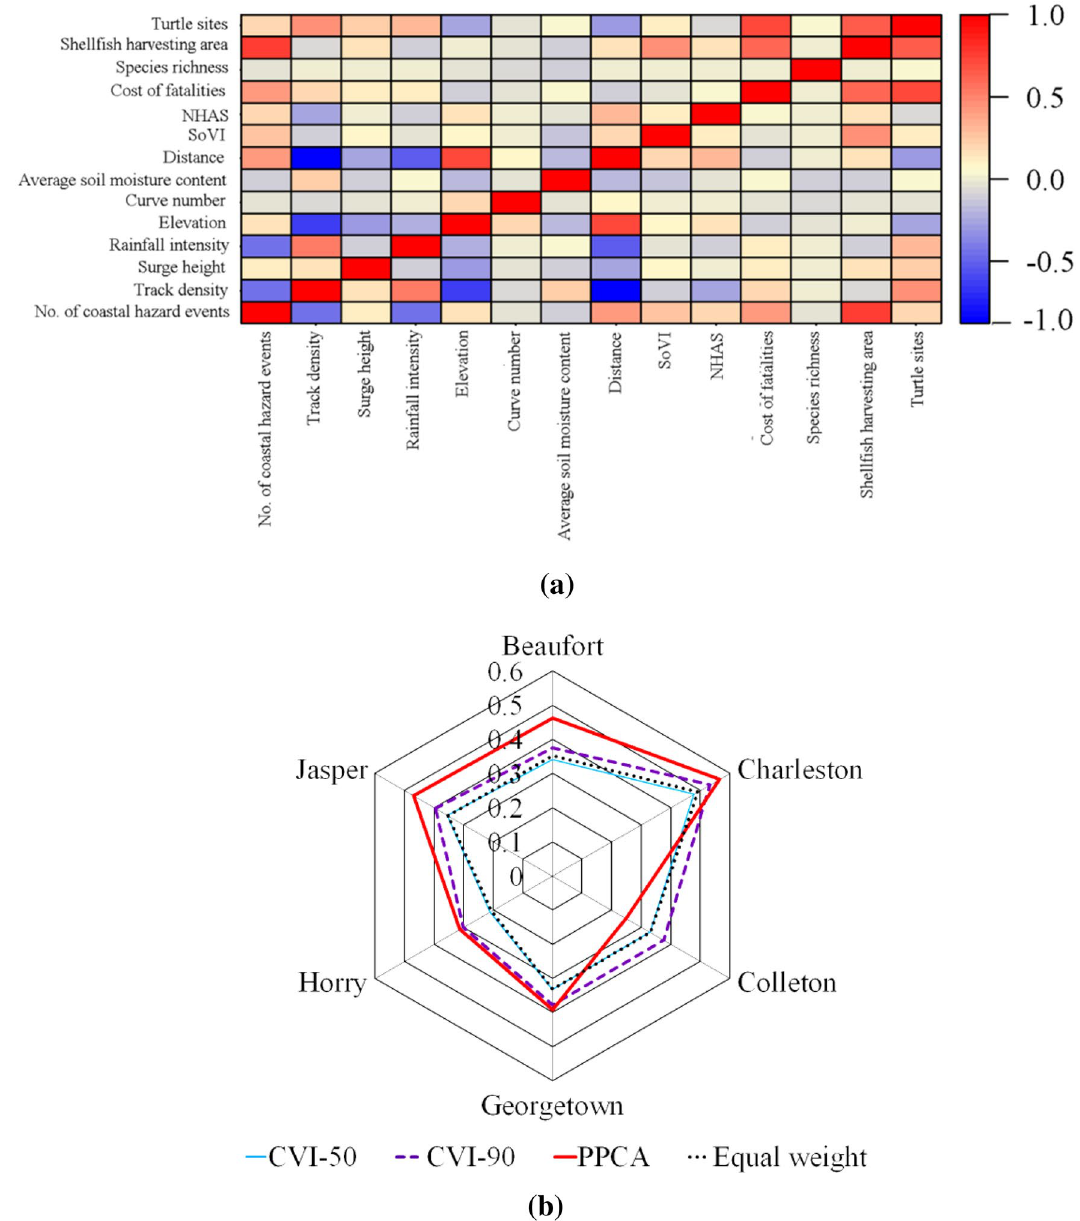
Figure 14. ( a ) Spearman correlation matrix of the vulnerability indicators. ( b ) Variation of mean CVI in six coastal counties with different